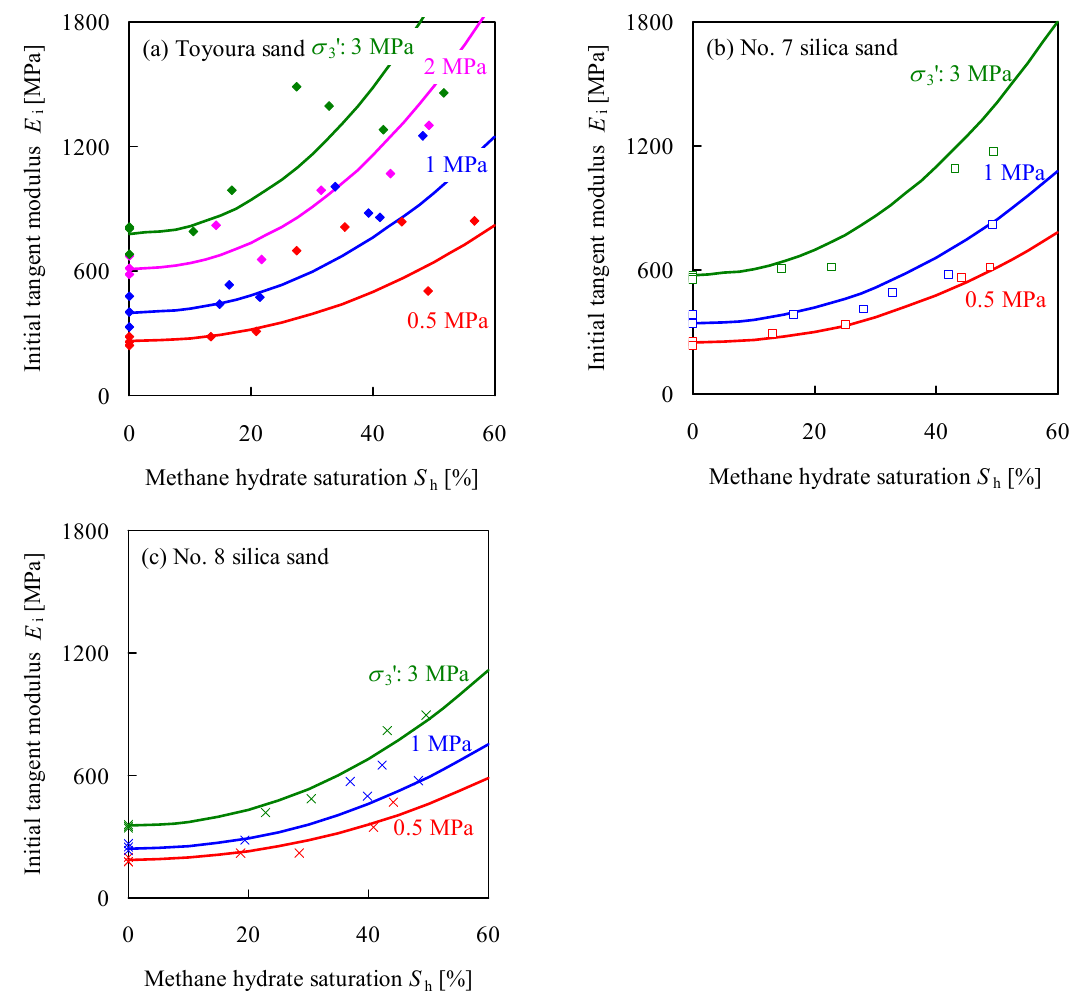
Figure 8. Initial tangent modulus E formed by ( a ) Toyoura sand; ( b ) No.7 silica sand and ( c ) No.8 silica sand. The curves are calculated using Equation